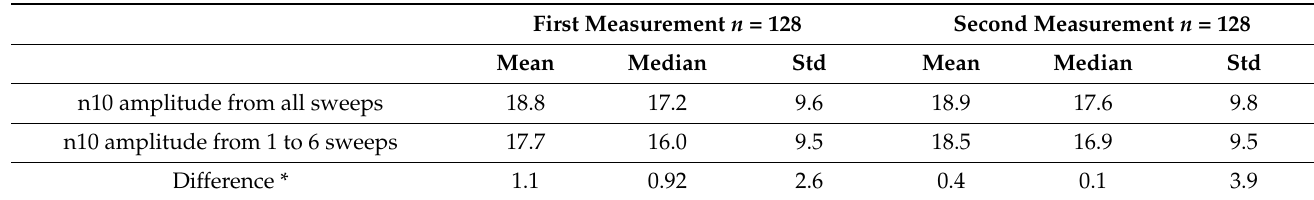
Table 1. Calculated values of the n10 amplitude with mean, median, and standard deviation (std) for the first and the second measurements. * The difference of n10 amplitude (the first vs. the second measurements) was significant ( p ≤ 0.038) in the Mann-Whitney-U testing.